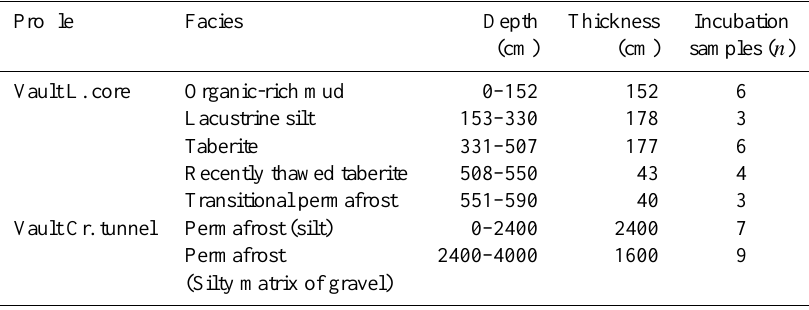
Table 2. Vault Lake core and Vault Creek permafrost tunnel facies, their depths and thicknesses, and the representative number of samples used in anaerobic laboratory